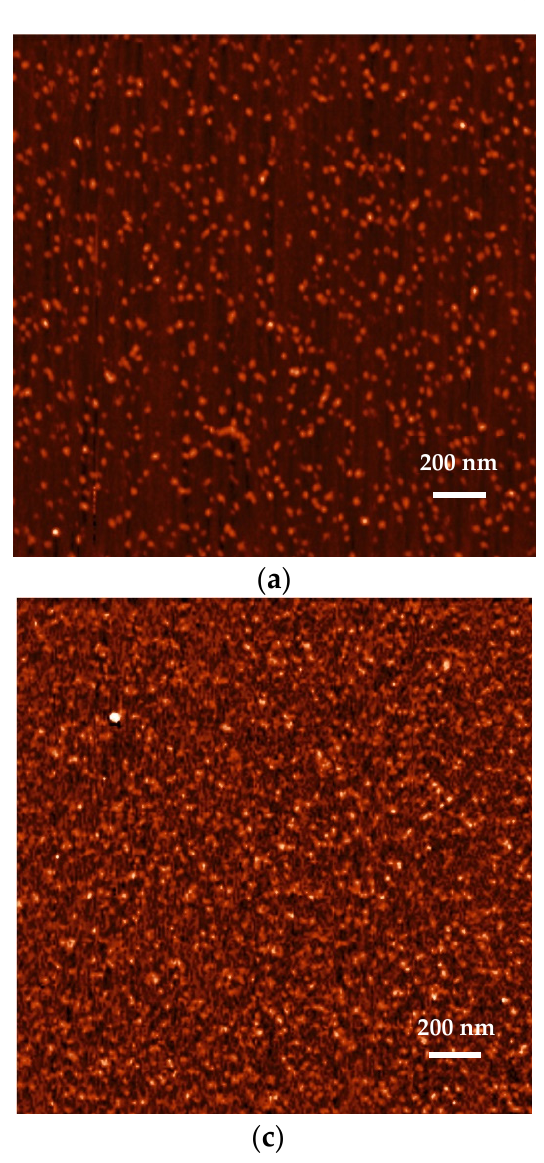
Figure 5. S1R protein layers on mica (AFM micrographs); adsorption conditions: pH 5.6, c b = 2 mg L − 1 , 150 M NaCl. Part a : t = 15 min (protein surface concentration 250 μ m − 2 ), part b : t = 30 min (protein surface concentration 350 μ m − 2 ); part c : t = 60 min (protein surface concentration 450 μ m − 2 ).